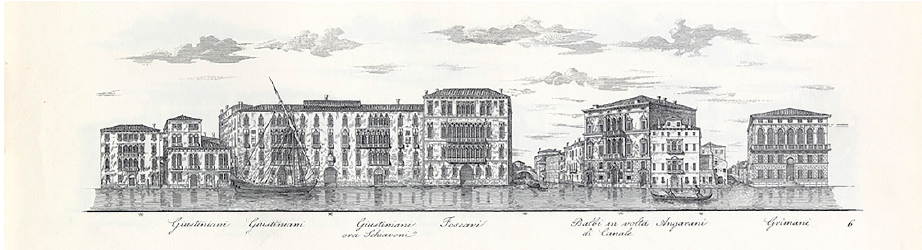
Figure 4. A. Quadri, D. Moretti, Elevation of the Canal Grande of Venice, 1831, Drawing 6.